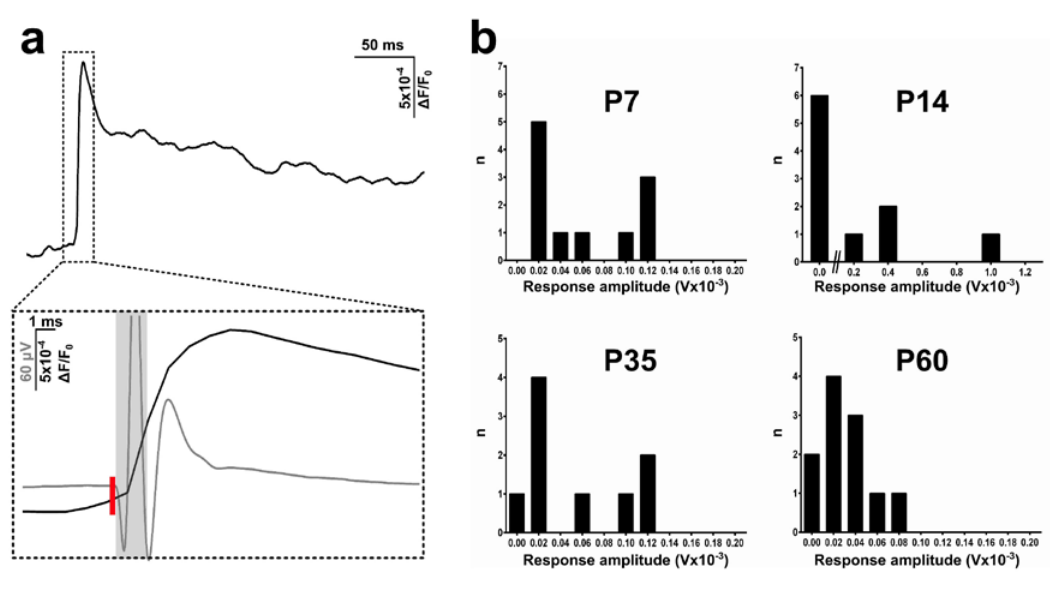
Figure 3. Comparison of VSDI (voltage-sensitive dye imaging) and electrophysiological signals and LFP (local field potential) recordings across different post-developmental stages. ( a ) Average of a representative VSDI trace from a P14 rat ( top ). The inset ( bottom ) shows VSDI and LPF traces superimposed and phase-locked from the same experiment. VSDI signal (black line) has a slower rising phase following stimulation (red bar), while field excitatory post synaptic potential (fEPSP) (grey line) reaches the peak before and has a faster decay. The light grey rectangle indicates a stimulation artefact. ( b ) Frequency distribution of post-stimulus response amplitudes at different ages. Early postnatal rats (P7–P14) are characterised by variable behaviour presenting a higher number of strong responses (>80 µV), while with maturation, this pattern shows a more conspicuous number of lower amplitude recordings. For (b): P7, n = 11 recordings; P14, n = 10; P35, n = 9; P60, n = 11.